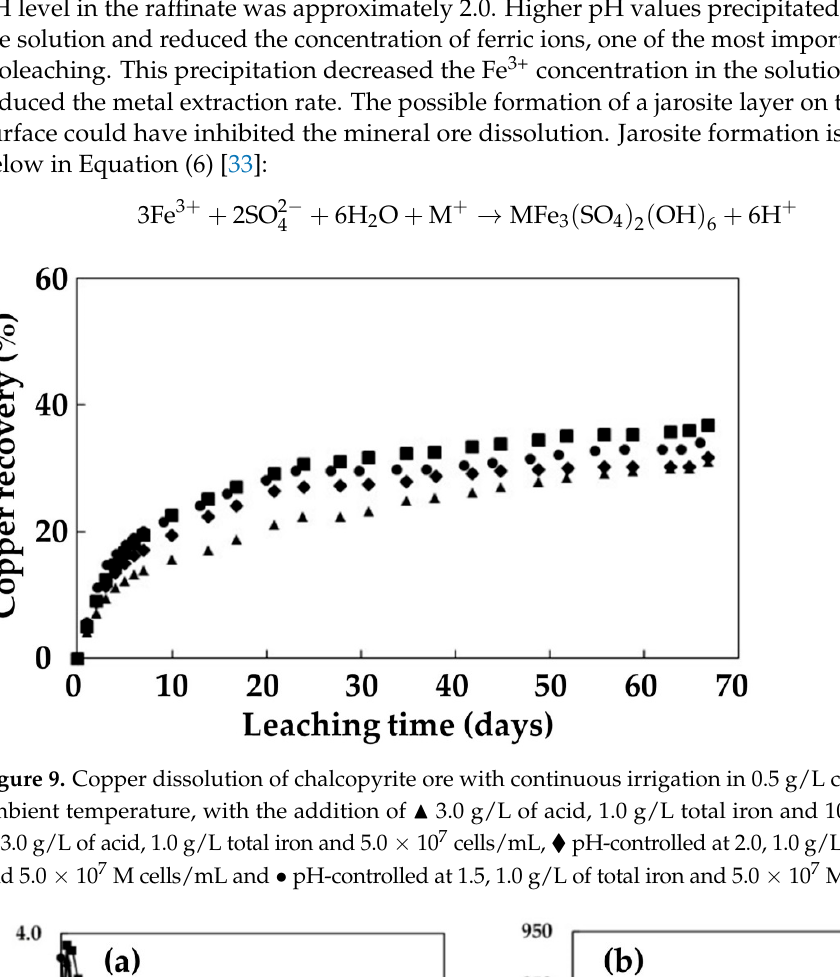
Figure 8. Copper dissolution ( ● ) from chalcopyrite ore in 10 g/L acid (pH 1.0), 0.5 g/L copper (II), and 1.5x10 8 cells/mL from the second cycle at ambient temperature with three intermittent irrigation cycles of 5/10 days. ( a ) Variation in pH (dashed line); ( b ) variation in Eh (dashed line).